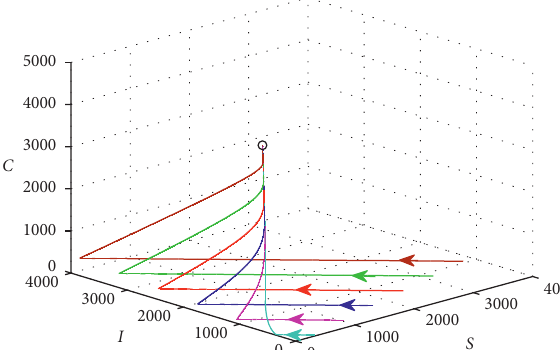
Figure 3: Six orbits of system (1) with different initial